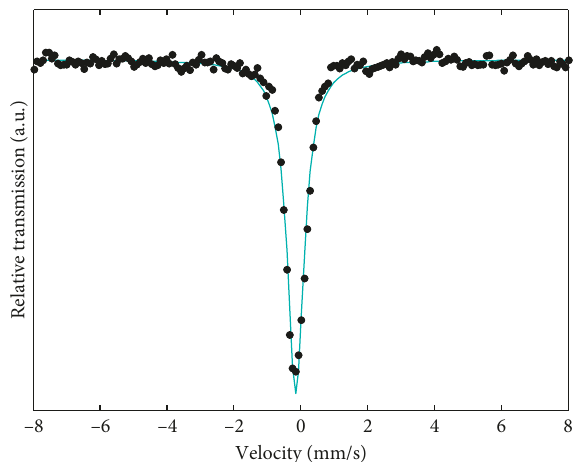
Figure 8: M¨ossbauer spectra for Fe-30Mn-5.9Si-0.1C powders after MA for 30h.